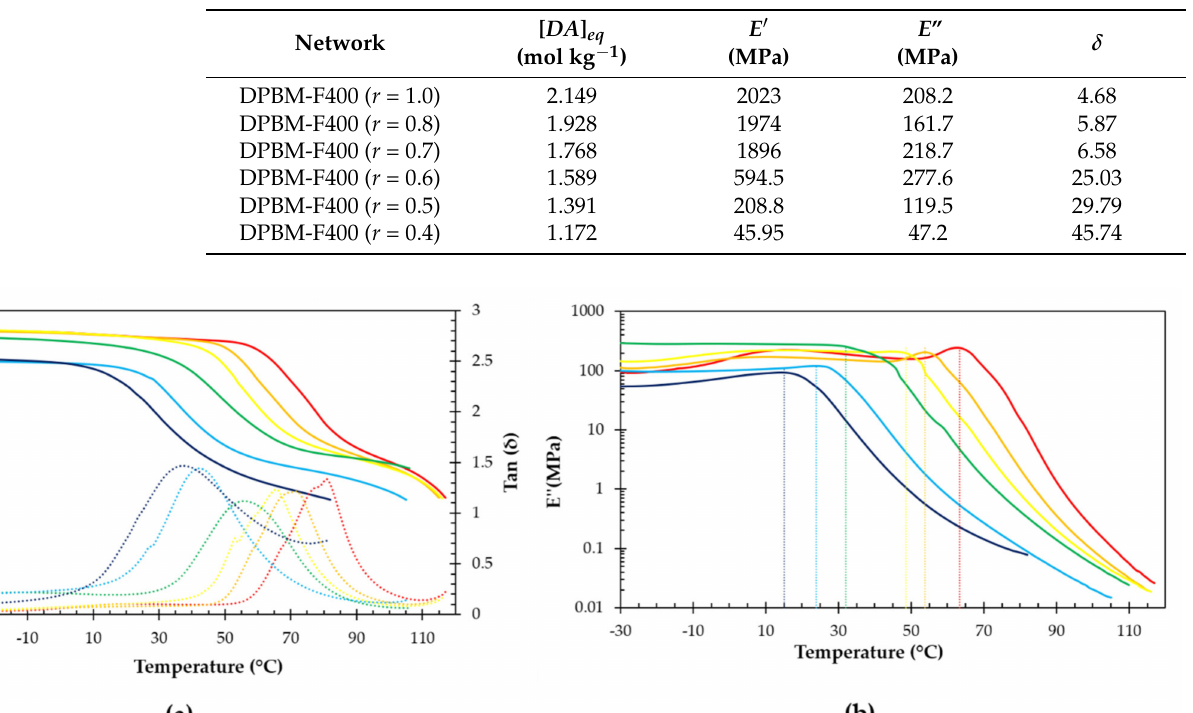
Table 3. Equilibrium crosslink density, storage modulus ( E’ ), loss modulus ( E” ) and loss angle ( δ ) at 25 ◦ C for the six RPNs that differ in stoichiometric ratio ( r ).